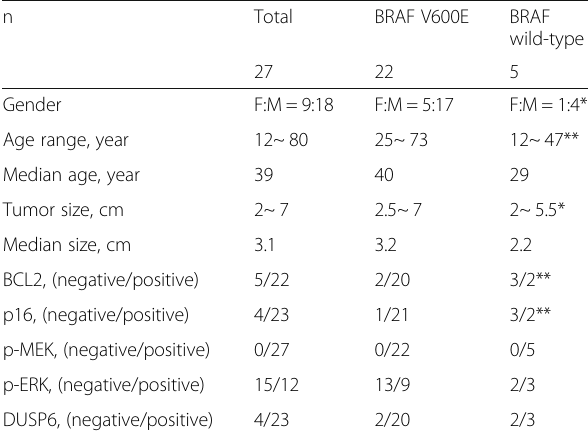
Table 4 Patient characteristics between BRAF V600E and BRAF wild-type MA patients